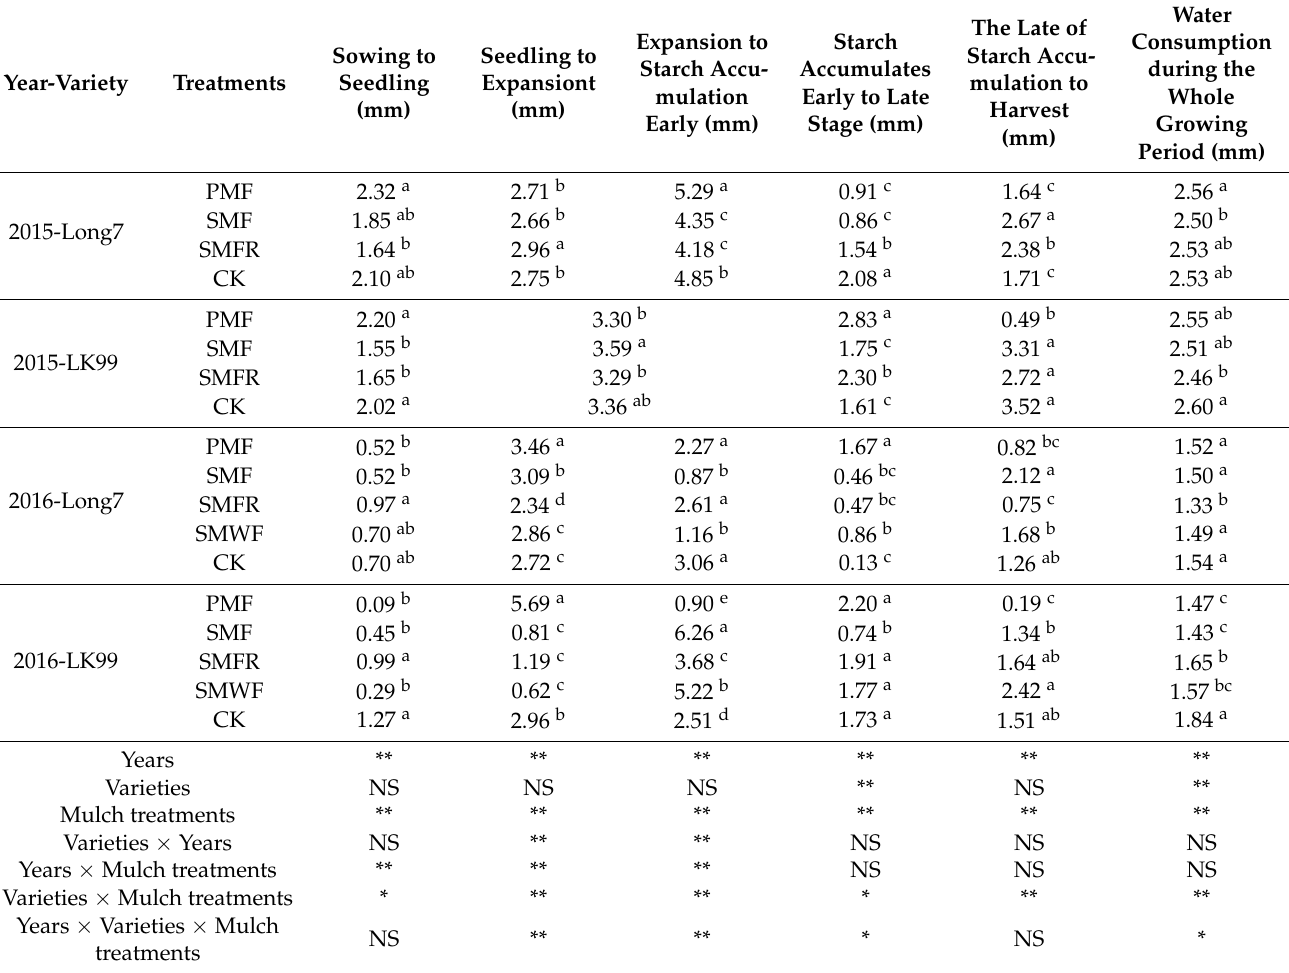
Table 1. The daily average water consumption of different treatments at different growth stages.